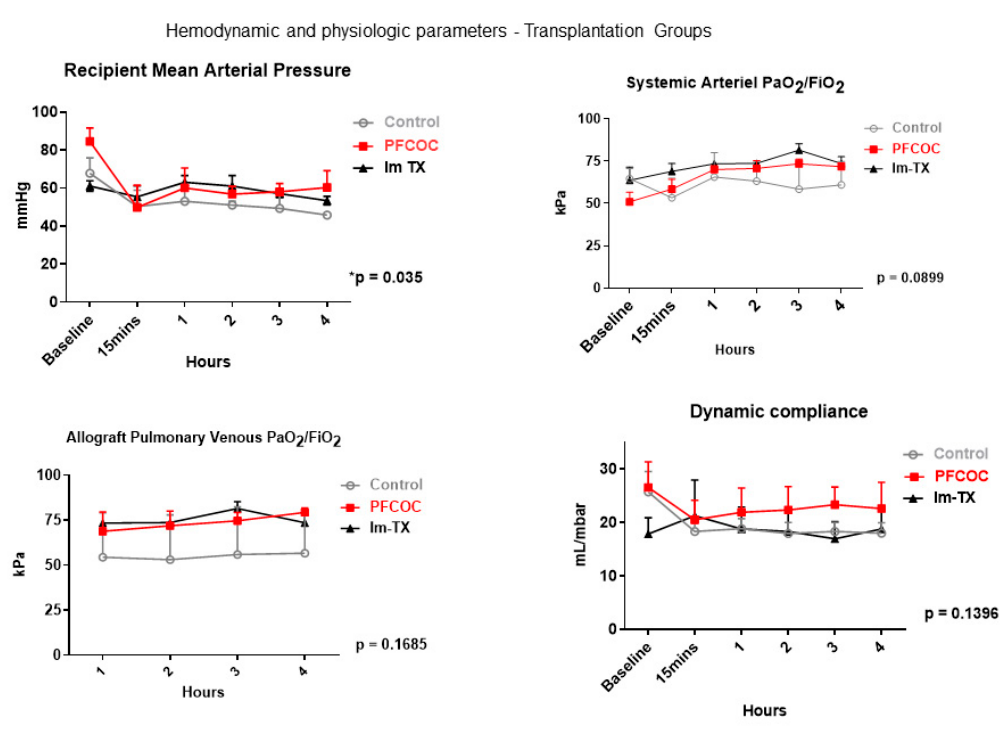
Figure 4. Hemodynamic and physiologic parameters during the 4 h of reperfusion. Im-Tx: Immediate transplantation group. Two-way analysis of variance (ANOVA) for repeated measures. Control: control group, PFCOC: perfluorocarbon-based oxygen carrier group.